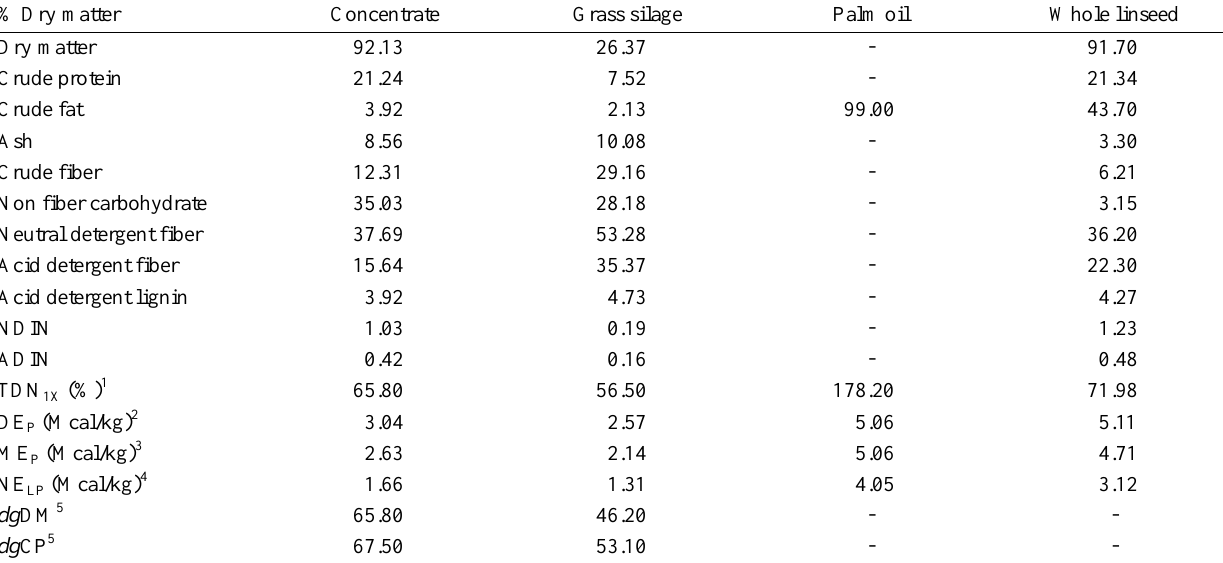
Table 1. Chemical composition of concentrate and grass silage used in the experiment % Dry